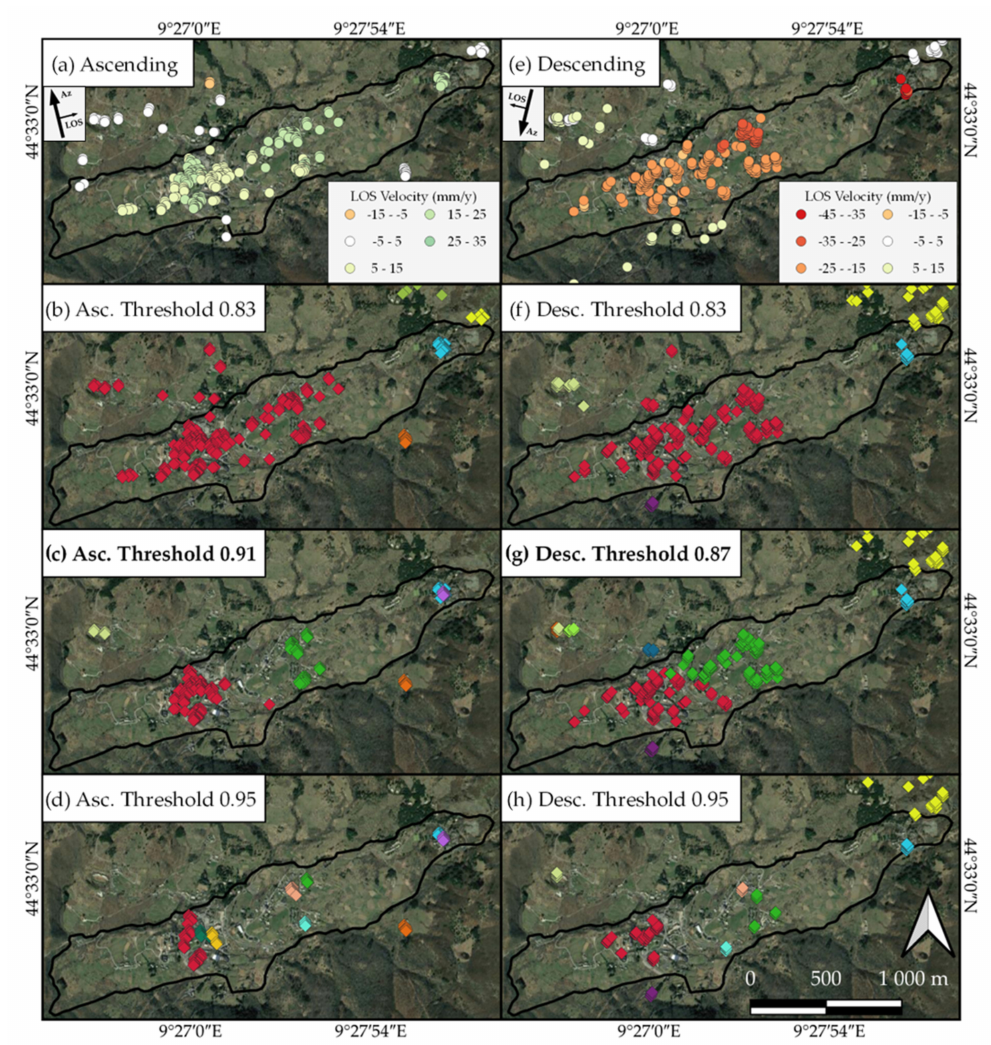
Figure 8. The Santo Stefano d’Aveto landslide, perimeter in black line according to IFFI [21], with: PS distribution in ( a ) ascending mode and ( e ) descending mode (colour code indicates different LOS velocity ranges), and their subdivision into families with CAPS method by using different threshold values for ( b – d ) ascending and ( f – h ) descending (different colours indicate different PS families). We applied CAPS to ascending and descending PS by using various threshold values, from 0.83 to 0.95. As specified in the previous paragraph, there are no objective